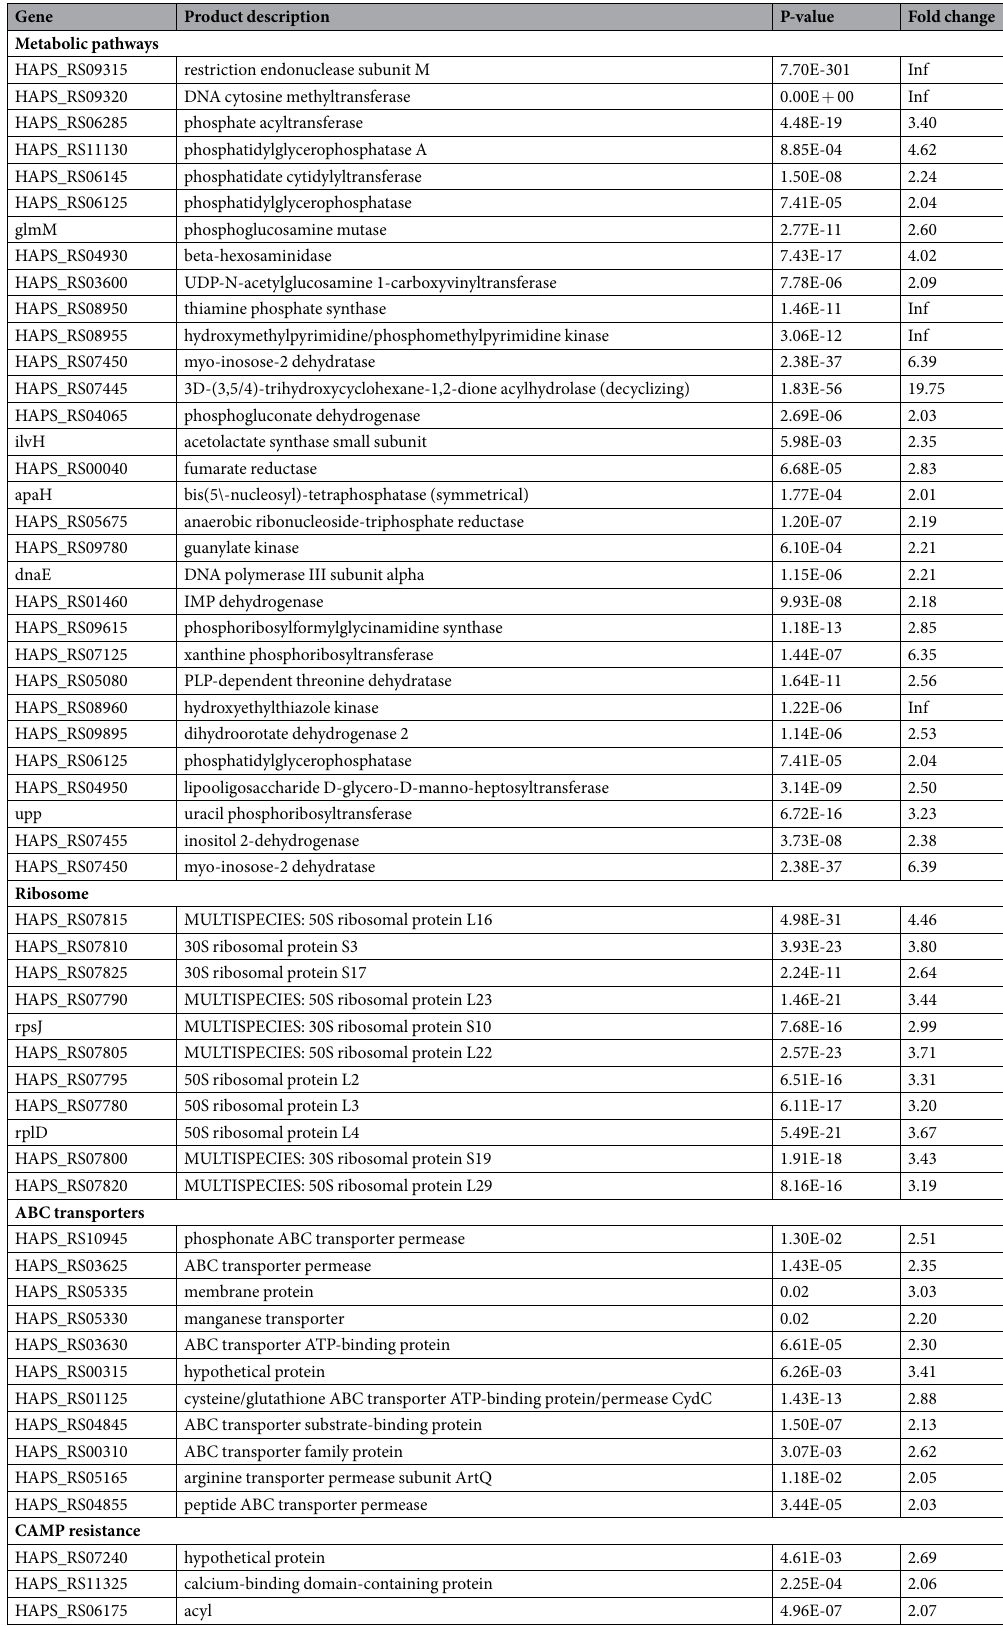
Table 3. The important up regulation genes of JS32 compared to JS0135 grouped by GO and KEGG pathways of interest. Note: Inf, represented